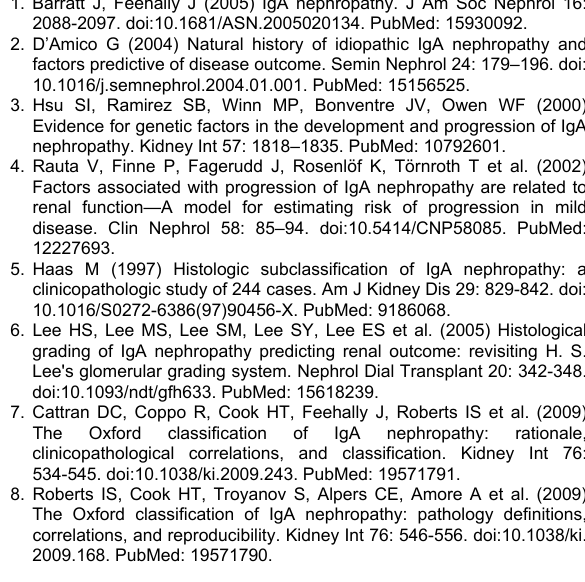
Table S5. The significant pathways enriched against KEGG database with related proteins and p-values for under-represented markers.